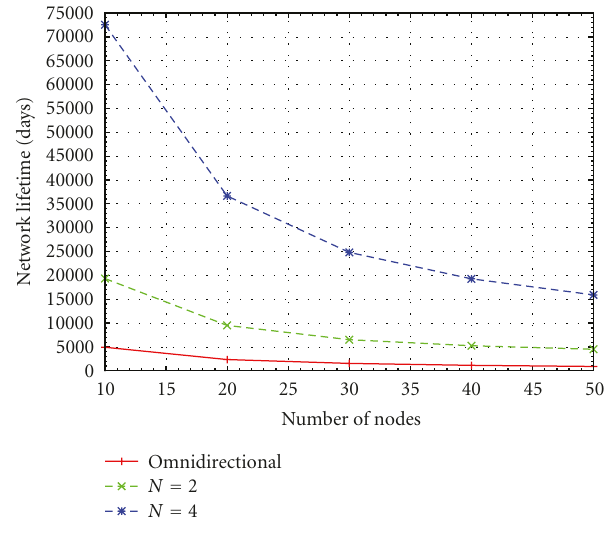
Figure 4: Network lifetime as a function of the number of nodes in the case of omnidirectional and directive antennas with π or π/ 2 main lobes for T f = 93seconds and δ = 3%.